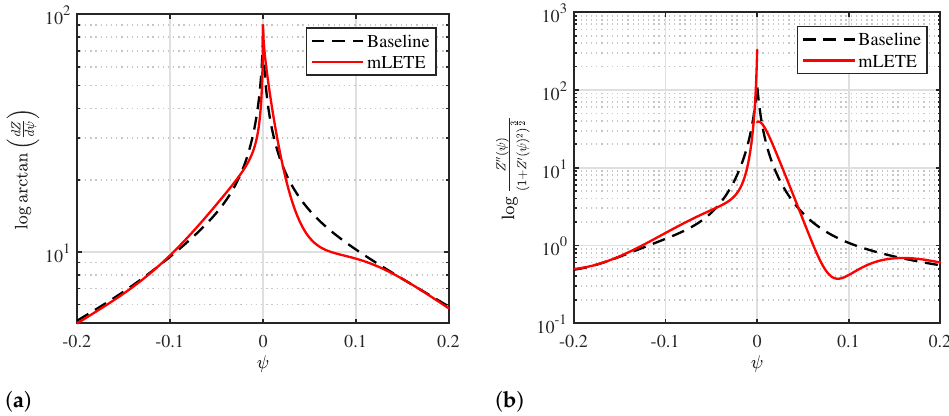
Figure 15. Slope and curvature of baseline and optimized mLETE airfoils. ( a ) Slope; ( b )